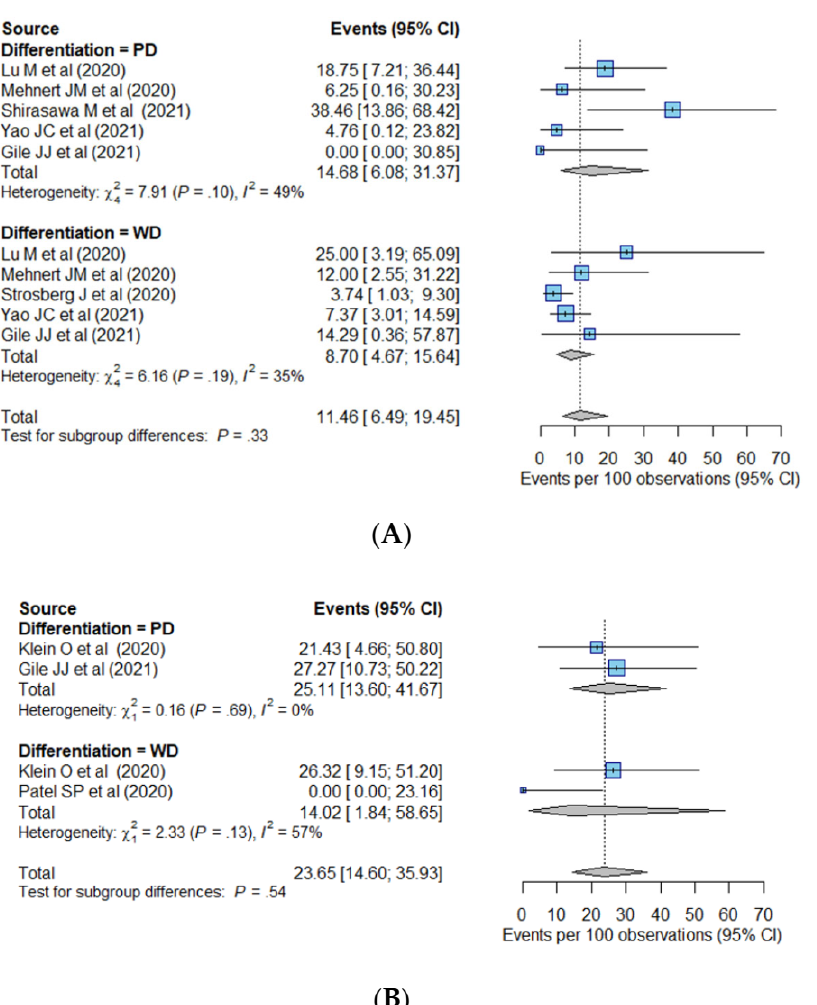
Figure 4. Sensitivity analysis according to tumor differentiation in the ( A ) monotherapy and ( B ) com- bination therapy groups. Abbreviations: CI, confidence interval; PD, poorly differentiated; WD,